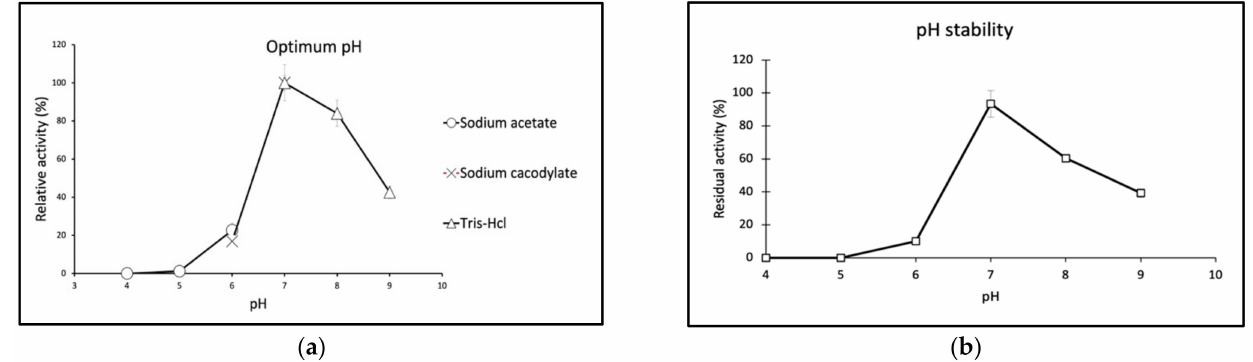
Figure 5. Effect of pH on enzyme ( a ) activity and ( b ) stability of purified Ga PIP. The optimal pH was determined by measuring enzyme activity in different buffer systems ranging from pH 3 to 9. The pH stability was determined by incubating an enzyme at different buffers for 30 min. The error bars represent the standard deviation ( n =